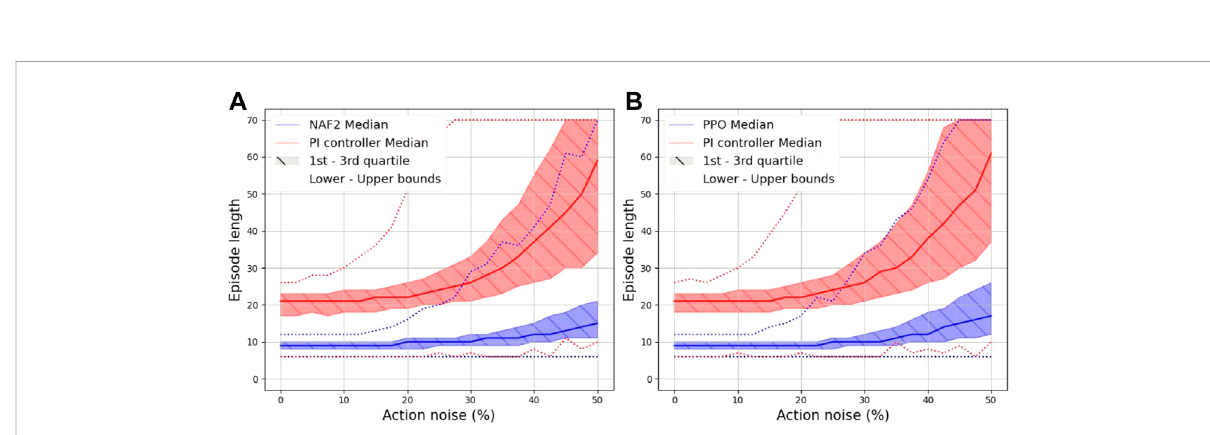
FIGURE 6 Effectofactionnoiseontheepisodelengthduetovaryingactionnoiseon (A) thebestNAF2agent, (B)